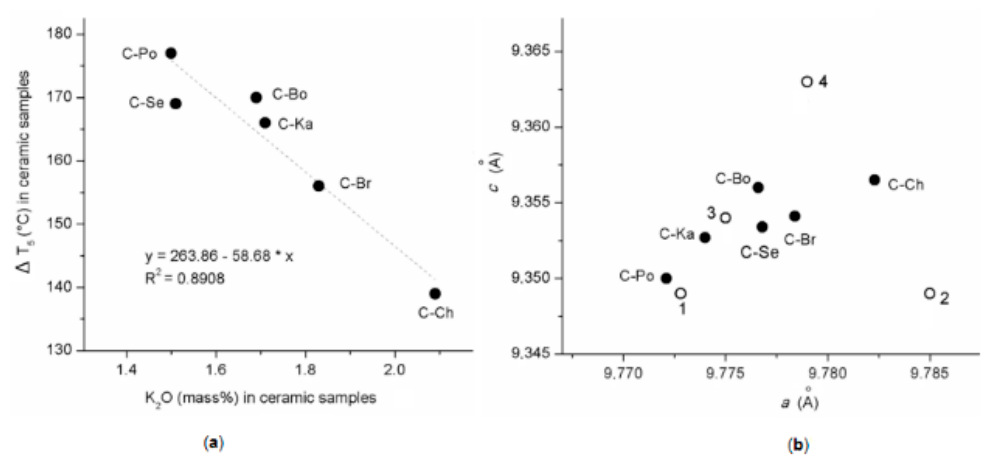
Figure 5. Relationsships between: ( a ) temperature ∆ T 5 vs. amount of K 2 O in ceramic samples and ( b ) unit cell parameters c vs. a of indialites. The parameters labeled as: 1: Mg 2.00 Al 4.00 Si 5.00 O 18 [4]; 2: Mg 2.00 Al 4.00 Si 5.00 O 18 [44]; 3: (K 0.17 Mg 1.94 Fe 0.06 Ca 0.04 )Al 4.25 Si 4.75 O 18 [38]; and 4: (K 0.25 Mg 1.75 )Al 4.25 Si 4.75 O 18